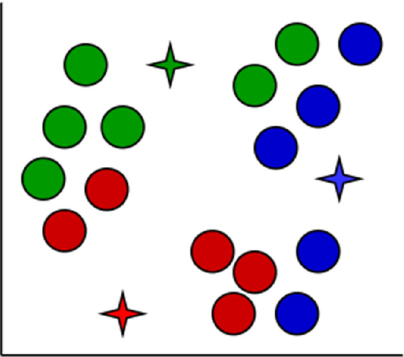
clidean Distance between data point X and Centroid C can be calculated using the formula.